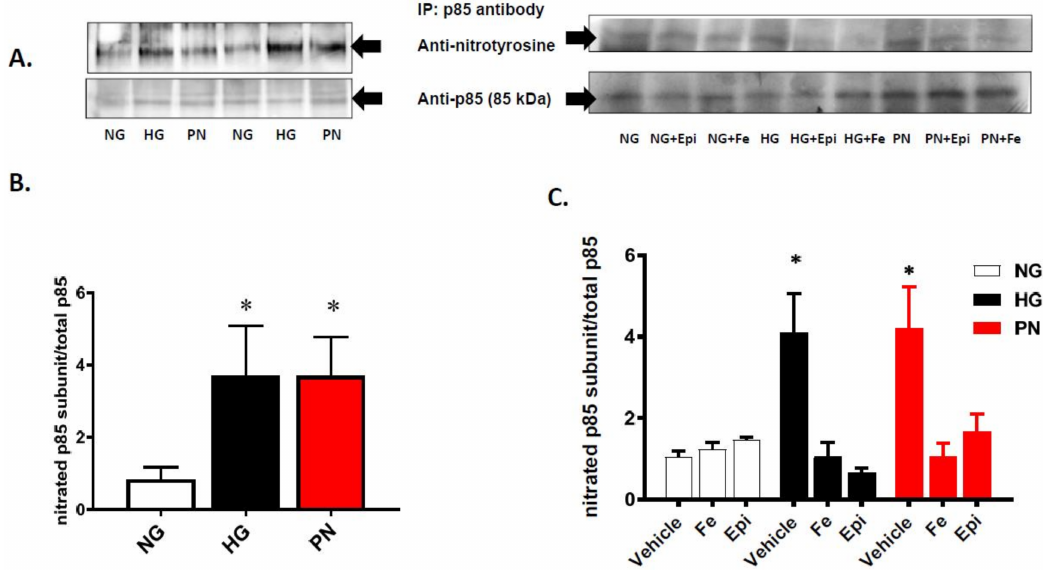
Figure 2. High glucose and peroxynitrite cause tyrosine nitration of the p85 subunit in ECs. ( A ) Representative blots of EC cultured in normal glucose (NG, 5 mM), high glucose (HG, 25 mM) for 3 days, or peroxynitrite (PN, 0.5 mM) overnight (left panel), alone or in the presence or absence of the specific peroxynitrite decomposition catalyst FeTTPs (Fe, 2.5 µ M) or the nitration inhibitor epicatechin (Epi, 100 µ M) (right panel). EC lysates were immune-precipitated with antibody against p85 subunit, and immunoblotted with antibodies that detect nitrotyrosine (NY) or anti-p85 s-subunit as loading control. ( B ) Statistical analysis of densitometry ratio of tyrosine-nitrated (NY) p85 subunit to total